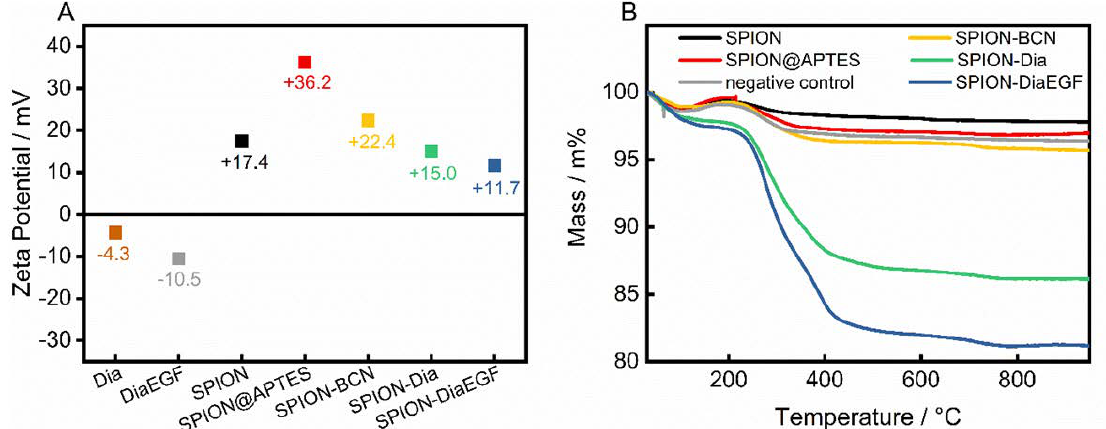
Figure 4. ( A ) Zeta potential measurements and ( B ) obtained thermograms after each functionalization